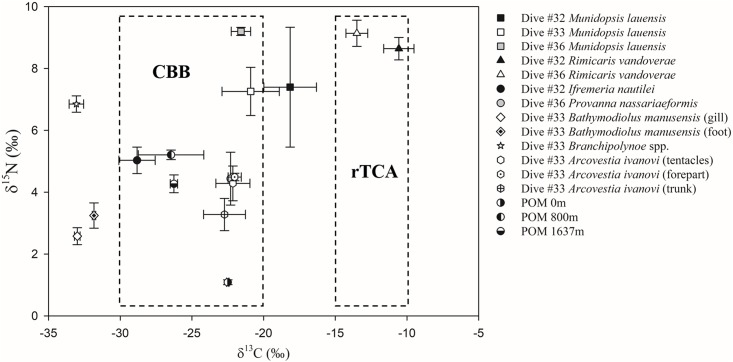
Average δ15N vs. δ13C values for the dominant species and POM from the PACManus hydrothermal area and the Desmos caldera.Dotted boxes represent different types of carbon fixation.